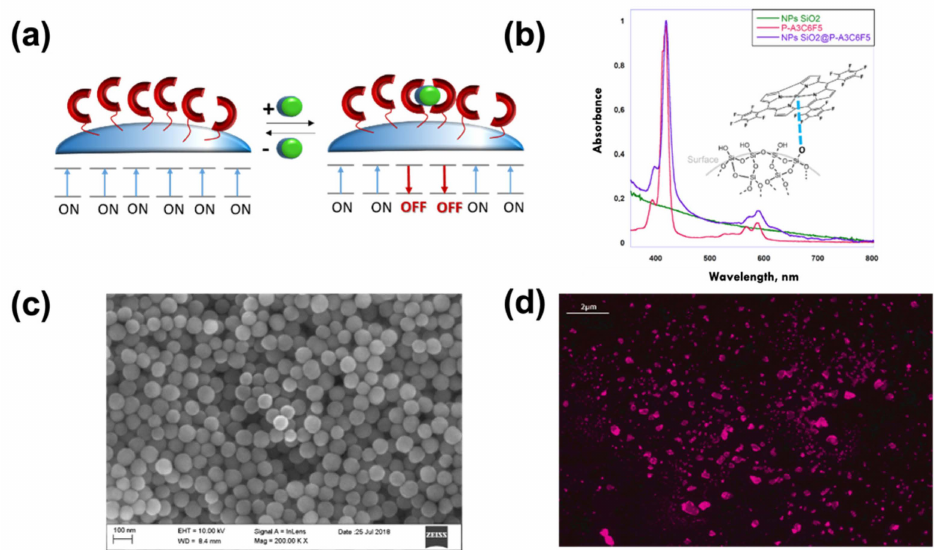
Figure 6. ( a ) Illustration of NPsSiO 2 @corrole dye–dye interaction’s effect on nitrite ion sensi- tivity; ( b ) the UV-vis spectrum; ( c ) SEM; and ( d ) the optical fluorescent microscopy images of SiO 2 NPs@ PFCorr hybrid assemblies. For optical fluorescent microscopy SiO 2 NPs@ PFCorr